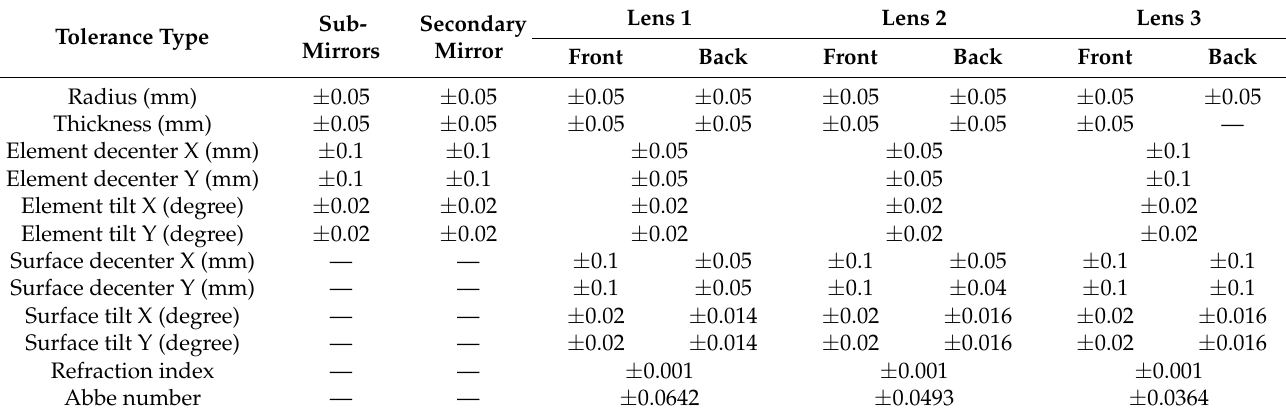
Table 5. The tolerance values of the Golay3